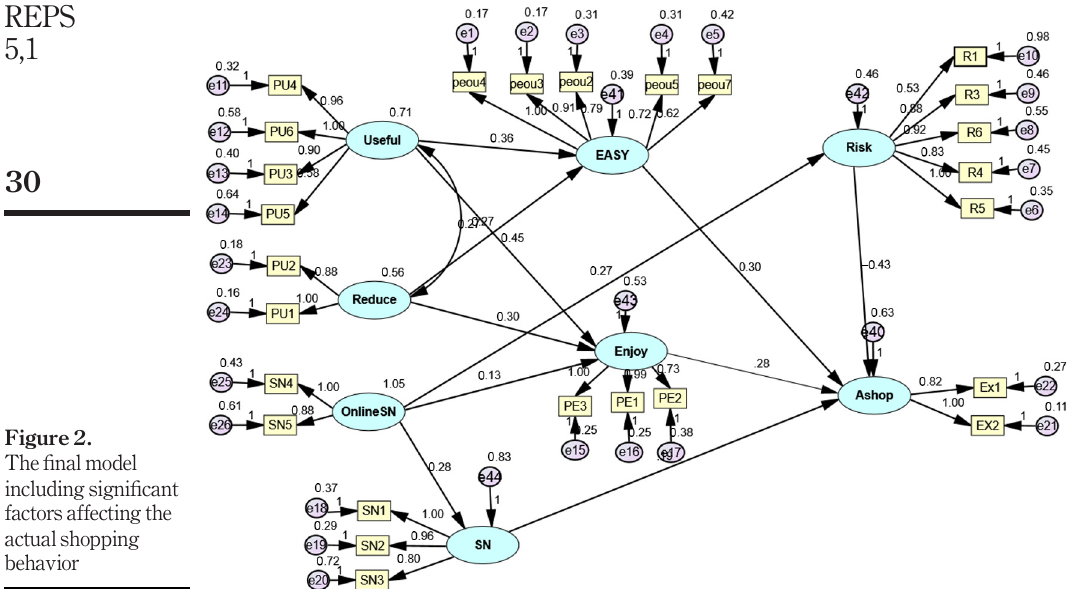
Figure 2. The fi nal model including signi fi cant factors affecting the actual shopping